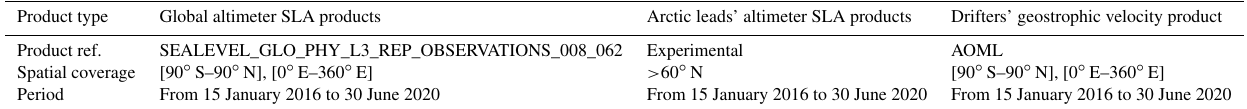
Table 1. List of observation datasets used in this study. Product type